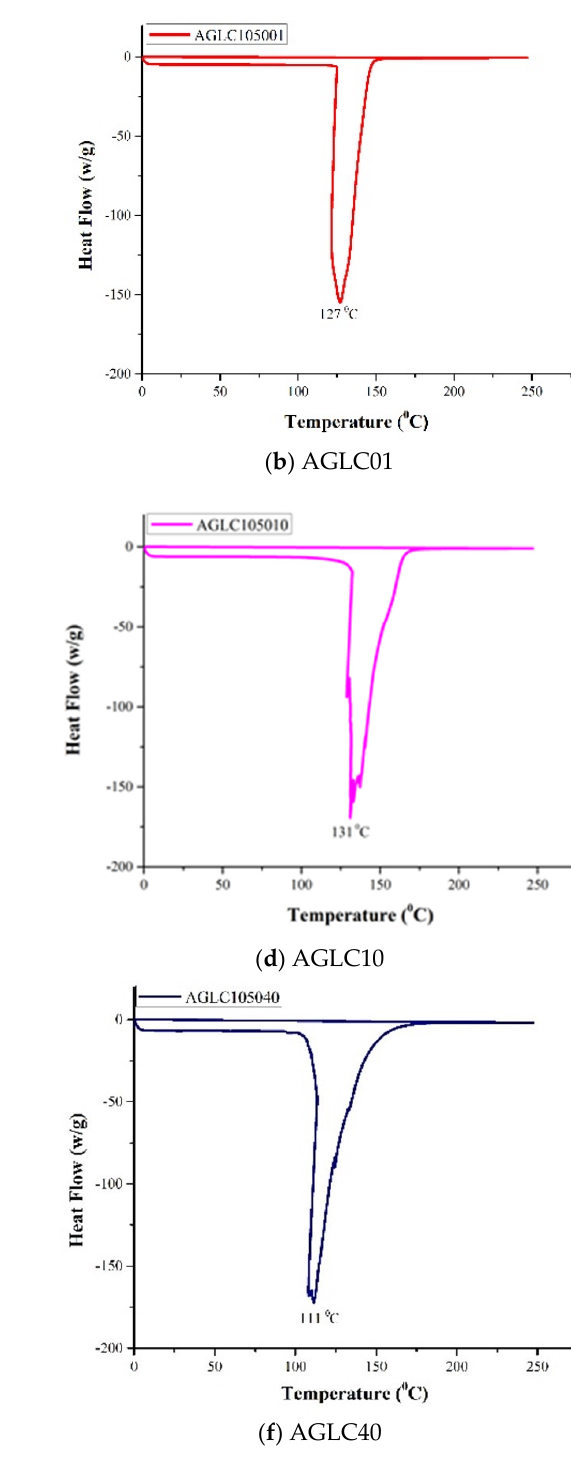
Figure 7. The DSC curves of ( a ) AG10:50, ( b ) AGLC01, ( c ) AGLC05, ( d ) AGLC10, ( e ) AGLC20, and ( f ) AGLC40.